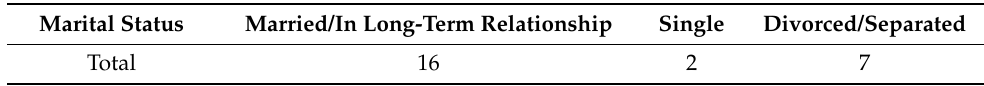
Table 3. Marital status of participants.